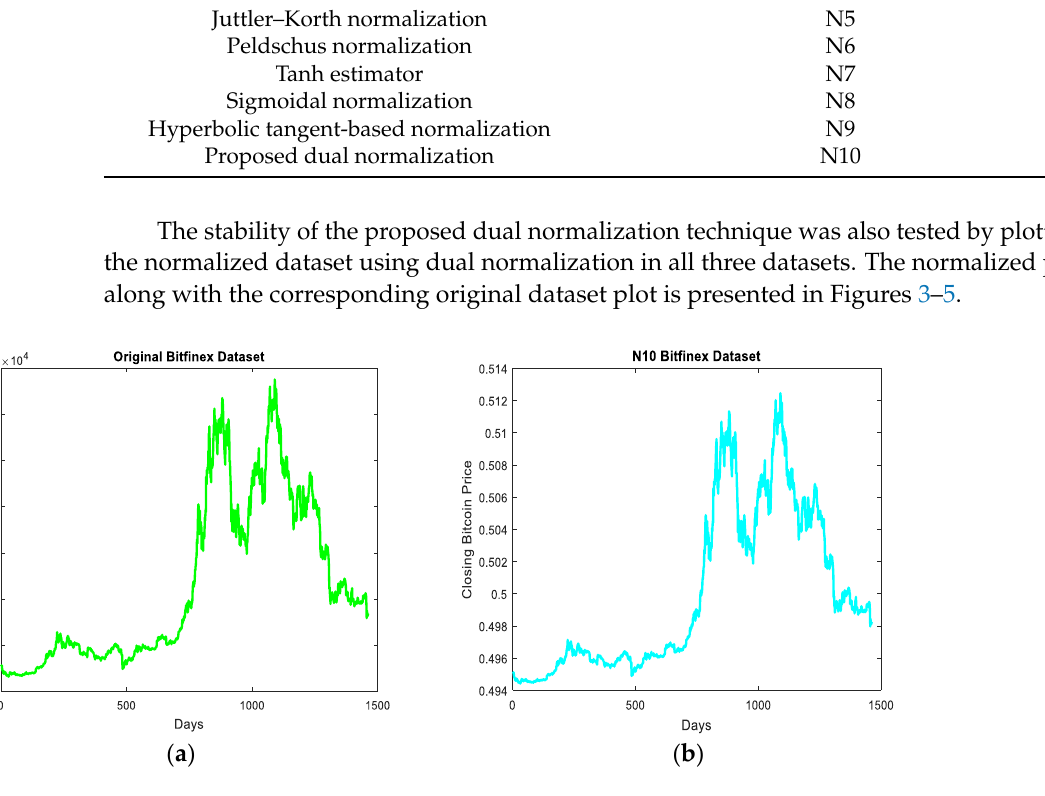
Figure 3. ( a ) Original Bitfinex dataset of closing Bitcoin price in US dollars ( b ) Normalized Bitfinex dataset using the proposed dual normalization.